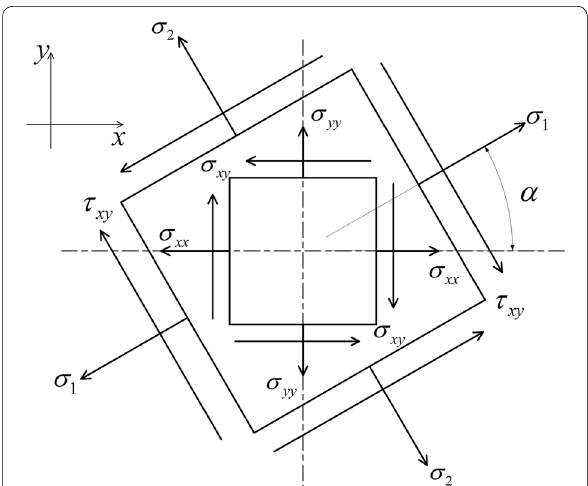
Figure 1 Stresses and corresponding directions at the angle α of the rolling direction